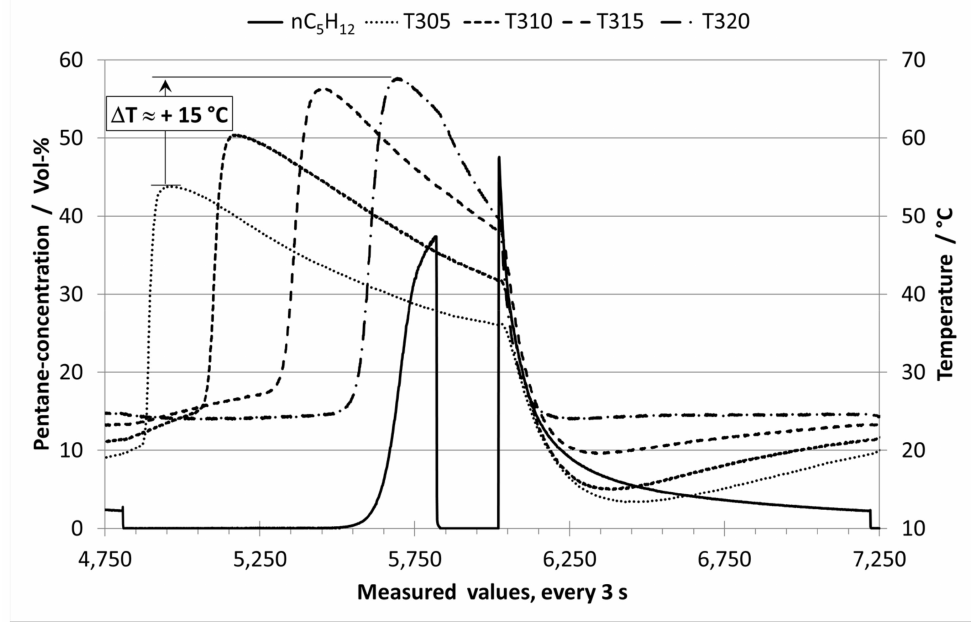
Figure 4. Concentration and temperature profile in the filter for E0/humid N 2 in 10th cycle.